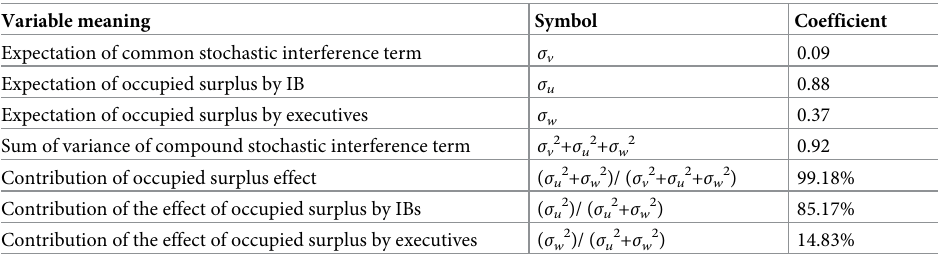
Table 5. Bargaining mechanism and variance decomposition